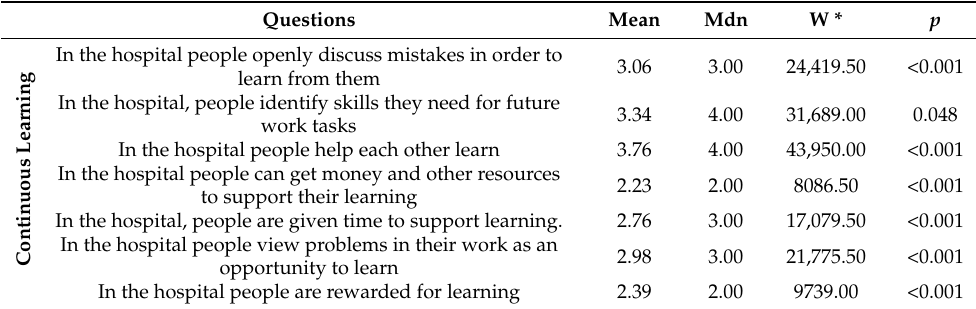
Table 4. Comparison of the individual characteristics of “Continuous Learning” dimension to the neutral value with the use of the one-sample Wilcoxon sign rank test.